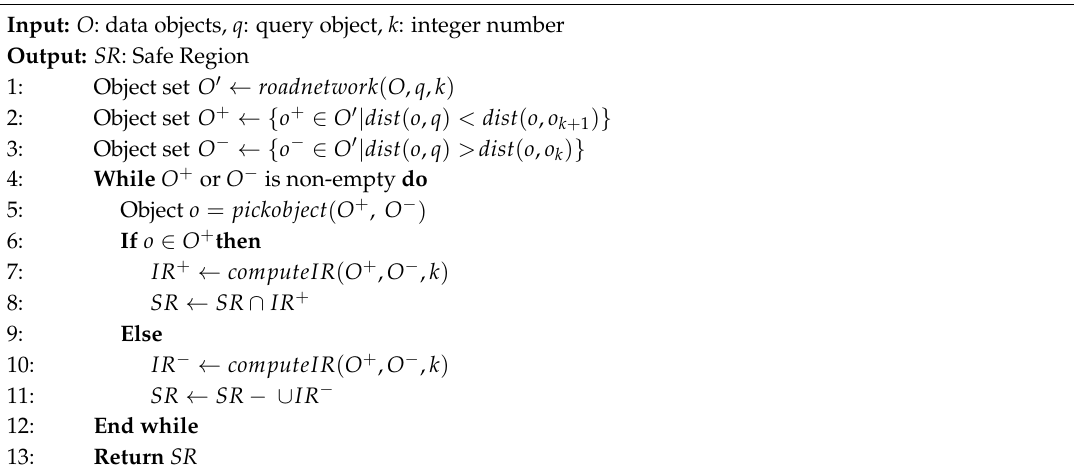
Algorithm 1: Computation of Safe Regions